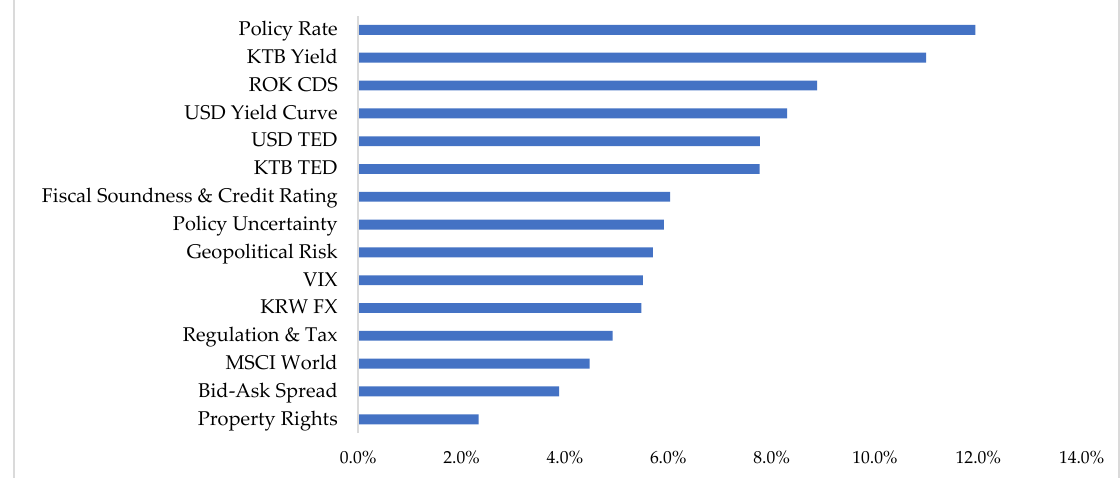
Figure 7. Global weights.